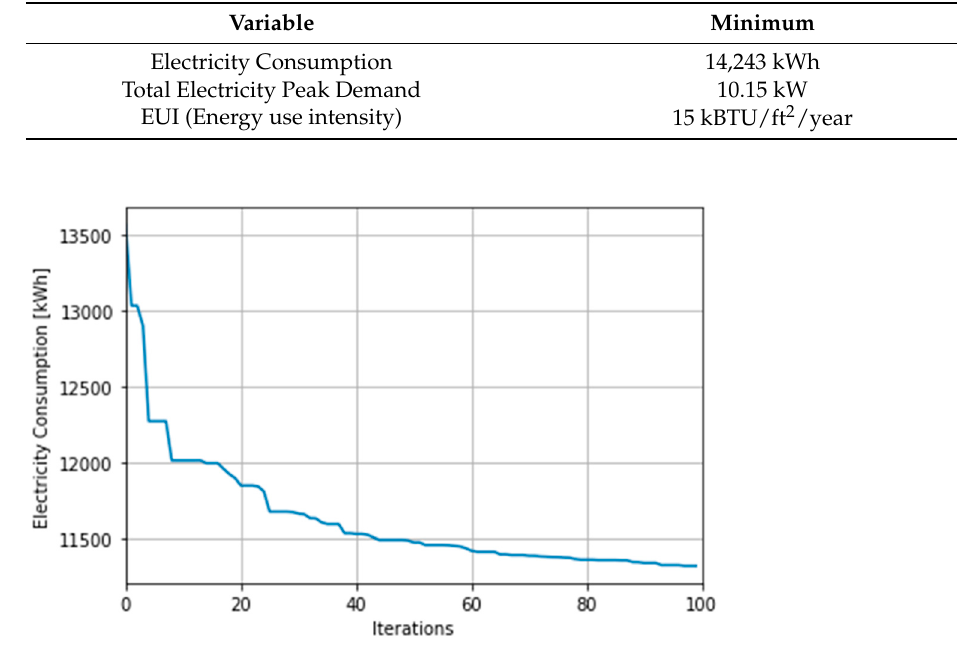
Figure 7. Minimizing building’s energy consumption (surrogate model) using genetic algorithm.